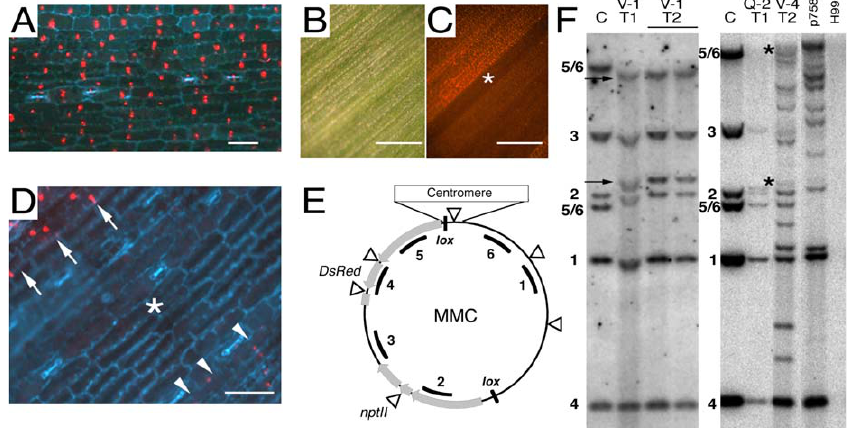
Figure 2. MMC Gene Expression and Structure (A) Fluorescent detection of nuclear-localized DsRed in MMC1 maize leaf; size bar, 50 l m. (B, C) Detection of DsRed sectors in a T2 plant leaf from event V-1 under (B) bright-field and (C) fluorescence microscopy; size bars, 0.5 mm. (D) high magnification view of image shown in (C) with the corresponding sector, comprising all cell layers, indicated by an asterisk; the edge of a sector that comprises only the adaxial cell layer is indicated by arrowheads, cells with typical DsRed expression are indicated by arrows. Size bar, 50 l m. (E) MMC consisting of a pCHR758 backbone and a centromere-derived insert, gene expression cassettes (grey), centromeric inserts (box), BglII restriction sites (arrowheads), and probes used for FISH and Southern blot analyses are indicated. (F) Southern blot of DNA digested with BglII and hybridized to probes 1–6 (E); Bands 1–4 measure 2,067, 3,167, 5,227 and 790 bp, respectively; those hybridizing to probes 5 and 6 vary in size, depending on the location of BglII sites within the centromeric DNA insert. MMC1 Control (c, lanes 1 and 5) DNA was purified from E. coli and hybridization patterns were compared to DNA from plant cell extracts derived from MMC1 events V-1 (lanes 2–4), Q-2 (lane 6), and V-4 (lane 7), as well as from plants transformed with pCHR758 (lane 8) and untransformed wild type (H99, lane 9). For events V-1 and Q-2, bands differing from bacterial grown controls are indicated (arrows and asterisk, respectively).